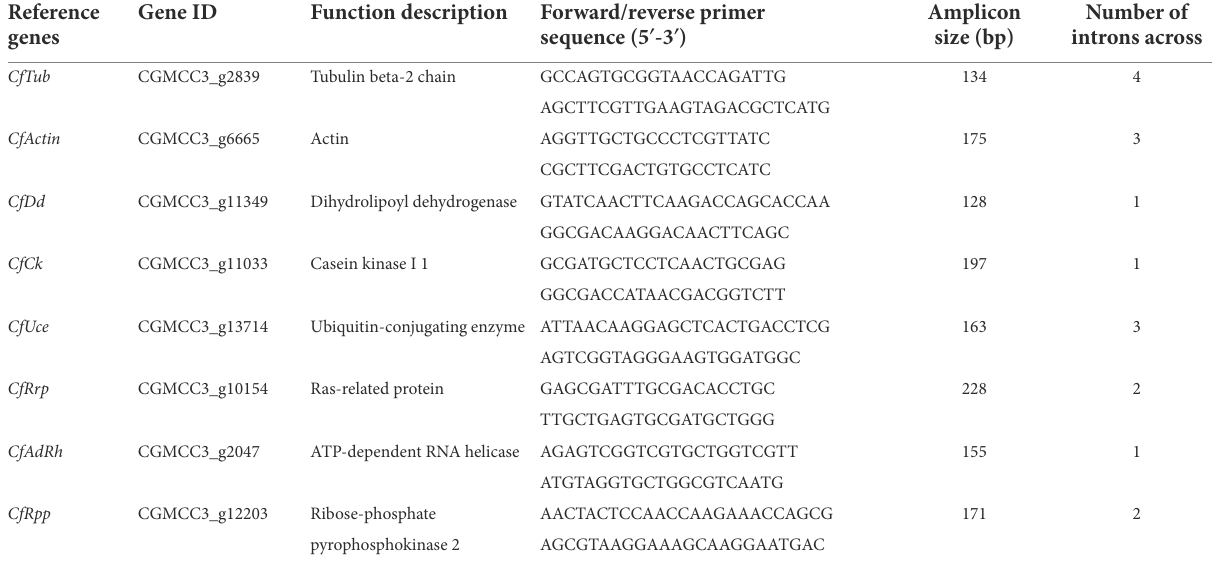
TABLE 1 Primer basic information of the candidate reference